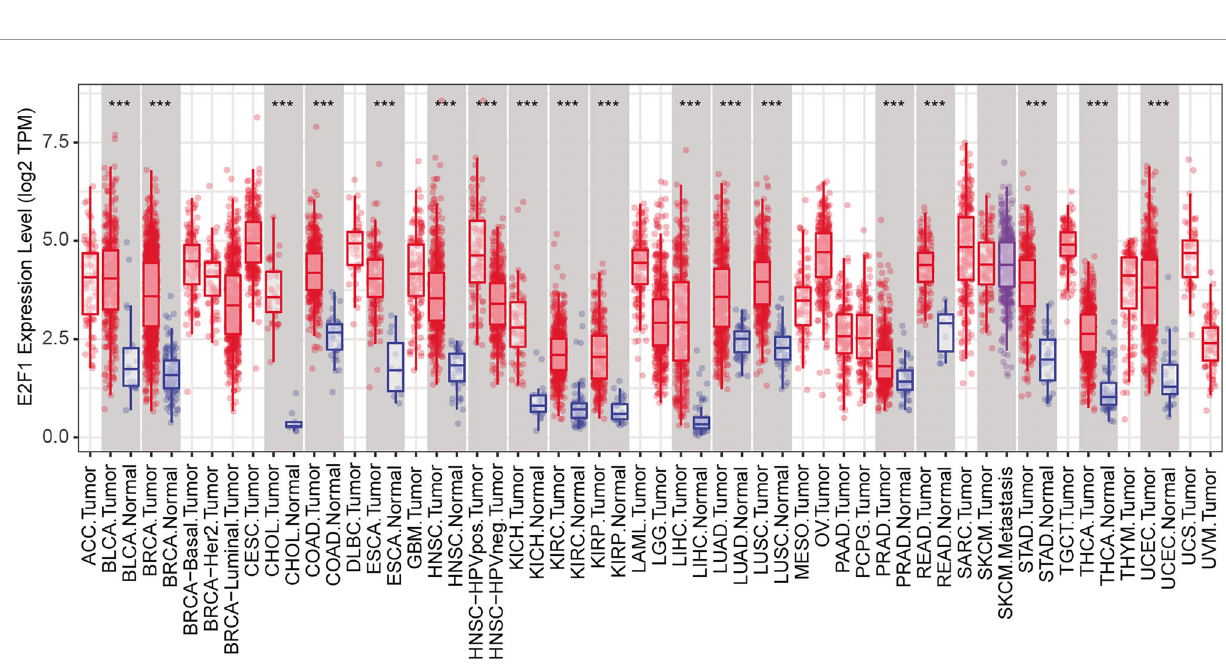
FIGURE 7 | Conserved expression pattern of E2F1 among various cancers. ***p.adj ≤